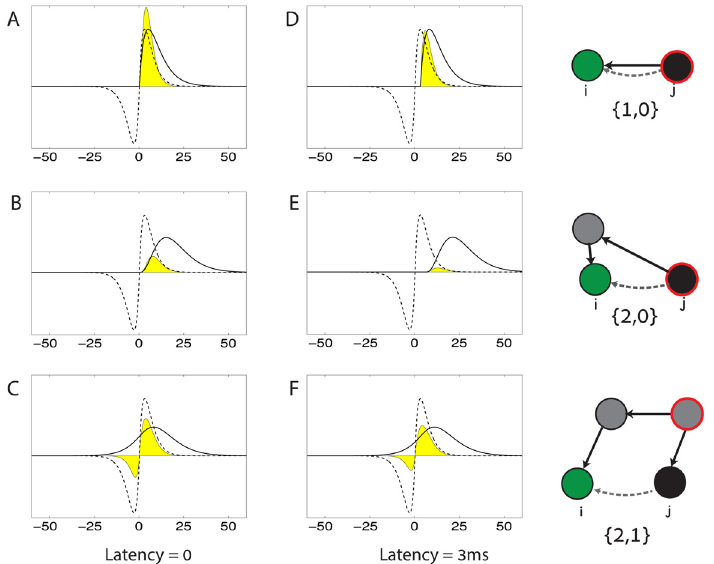
Fig 10. Dependence of motif coefficients on the time course of STDP and time course of post synaptic currents. A-F . Examples illustrating how the coefficients f α , β are determined for three motifs. Solid lines: motif driven spike correlations (Eq 18). Dashed lines: the STDP function (chosen to be antisymmetric). Yellow area: the integral of the product of these two functions, which determines the motif coefficient. For simplicity, we consider only the correlation structure induced by the excitatory synaptic connectivity. A . The correlation time course (solid line) induced by the motif {1, 0} is simply the synaptic current function. B . In comparison with A, the correlation time course induced by the motif {2, 0} peaks later and is more widespread, because the coupling between the pre and the post synaptic neurons is mediated through an intermediate neuron. C . The correlation function induced by the third order motif {2, 1} peaks at a similar time as in A, because in both motifs α − β = 1, meaning that the paths leading to neurons i and j differ in length by one synapse. D-F . A synaptic latency of 3 ms affects the overlap between the correlation time course and the STDP function, and thus the motif coefficients (see also Fig 5). D . In the motif {1, 0} the correlation time course is shifted by 3 ms relative to panel A, leading to a decrease in the overlap with the STDP function and a decrease in f 1,0 . E . In the motif {2, 0} the spike correlation function (solid line) is shifted by 6 ms relative to panel B because two synaptic latencies accumulate along the path from the pre synaptic neuron j to the post synaptic neuron i . The overlap with the STDP function and the coefficient f 2,0 are sharply reduced. F . In the motif {2, 1} the spike correlation function is shifted by 3 ms relative to panel because the relative latency, incurred along the paths from the source neuron to neurons i and j amounts to a single synaptic latency. The time course of correlations arising from this motif (solid line) is very broad, and therefore shifting it relative to the STDP trace has relatively little influence on the overlap with the STDP function and on f 2,1 .